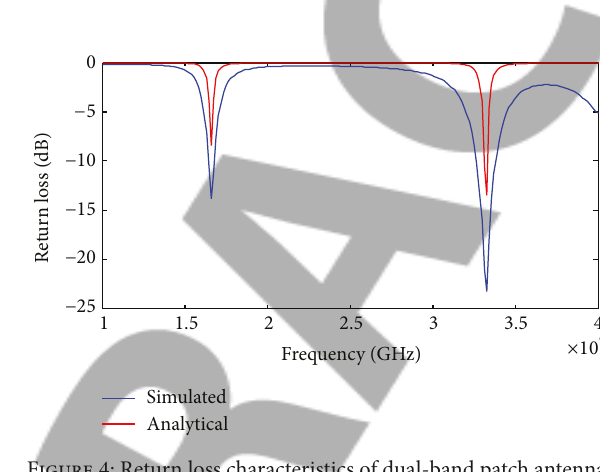
Figure 4: Return loss characteristics of dual-band patch